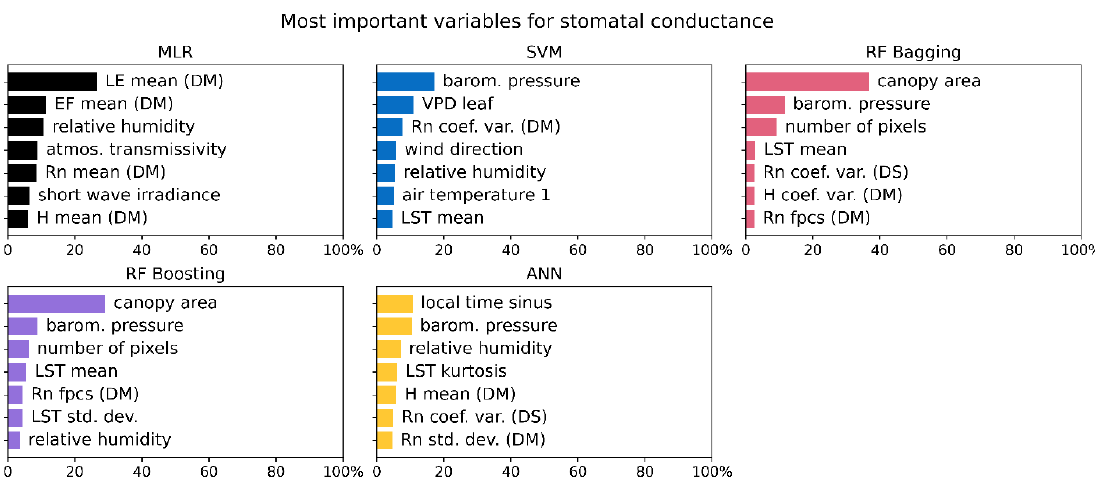
Figure 10. The seven most important input variables averaged over all data sets (different canopies and combinations) for the corresponding models when predicting stomatal